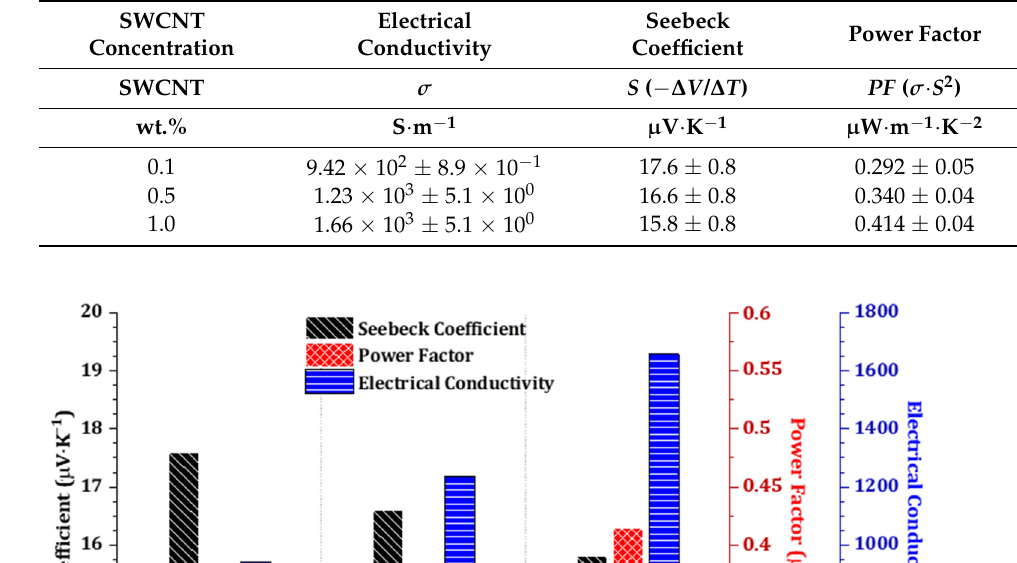
Table 3. Thermoelectric properties of 28-day one-part SWCNT-alkali-activated nanocomposites.